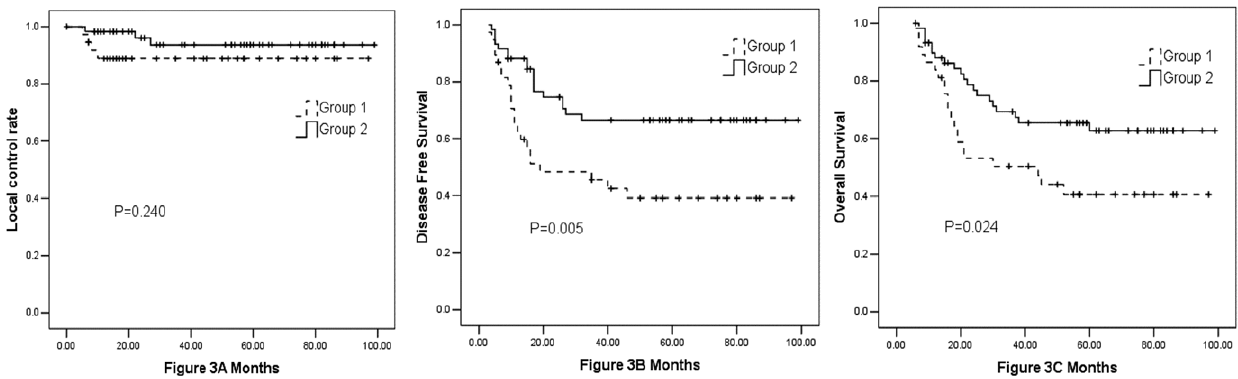
Figure 3. The local control rate, disease-free survival (DFS), and overall survival (OS) of patients in group 1 (0–3 cycles chemotherapy) and group 2(4–6 cycles chemotherapy) (Fig. 3A: local control rate, Fig. 3B: DFS, Fig. 3C: OS).